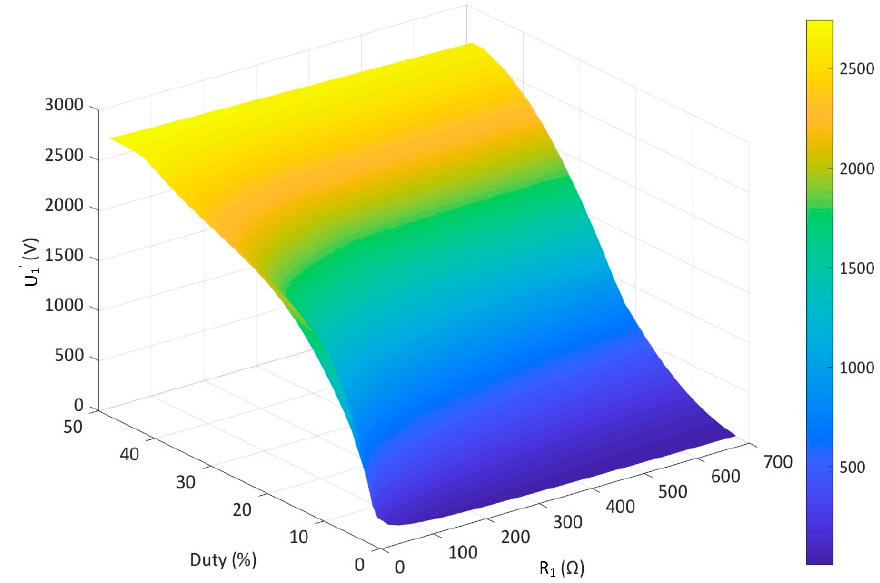
ff erent loads and duty